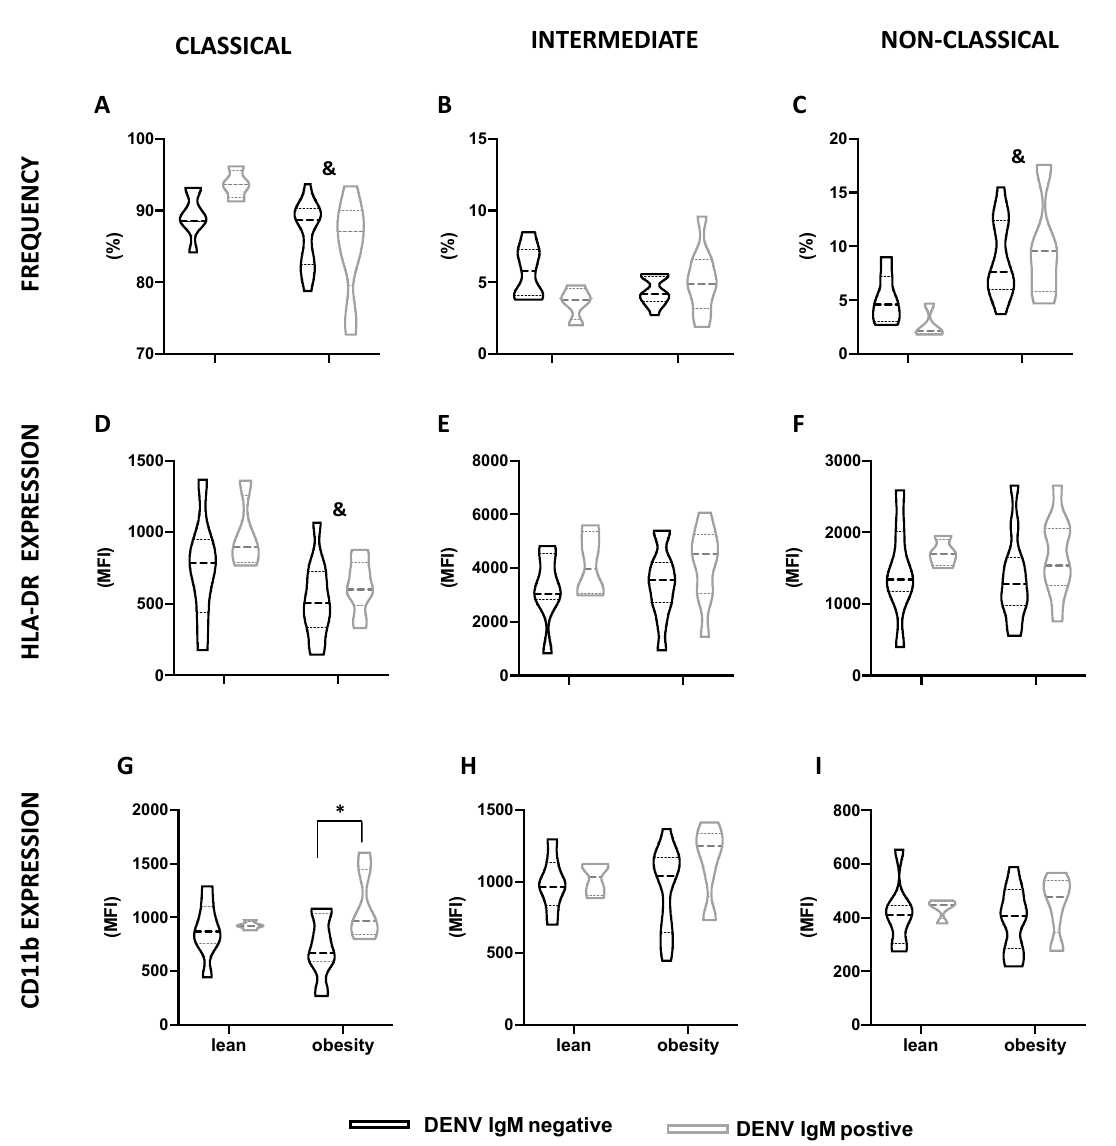
Figure 1. Monocyte subsets profile according to BMI and DENV IgM status. Classical ( A , D , G ), intermediate ( B , E , H ), and non-classical ( C , F , I ) monocytes distribution ( A – C ), HLA-DR ( D – F ) and CD11b expression ( G – I ) in lean individuals and individuals with obesity, according to DENV IgM status. Data are expressed as median (dashed line) and the first and third quartiles (dotted lines). & p < 0.05, lean versus obesity, irrespective of the DENV IgM status, two-way Anova. * p < 0.05, DENV IgM negative versus DENV IgM positive, two-way Anova, Š í d á k’s multiple comparison